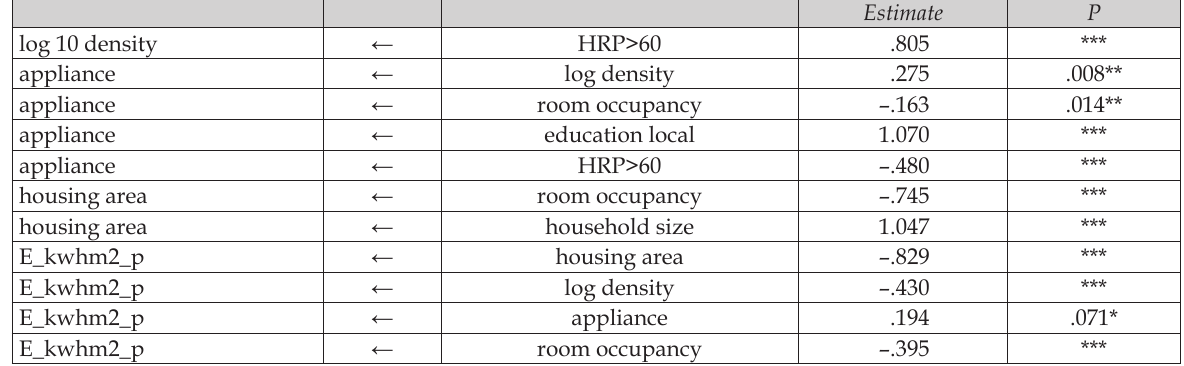
Table 10. Path analysis: significance of direct impact.